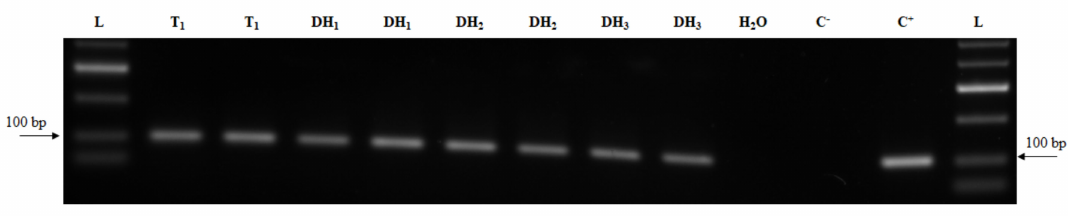
Figure 5. Detection of Cas9 transcript over three successive DH generations. L—DNA ladder (HyperLadder 50-bp, Bioline); C + —plasmid DNA; C – —wild-type cDNA sample; T 1 and DHs—cDNA samples of transgenic line and